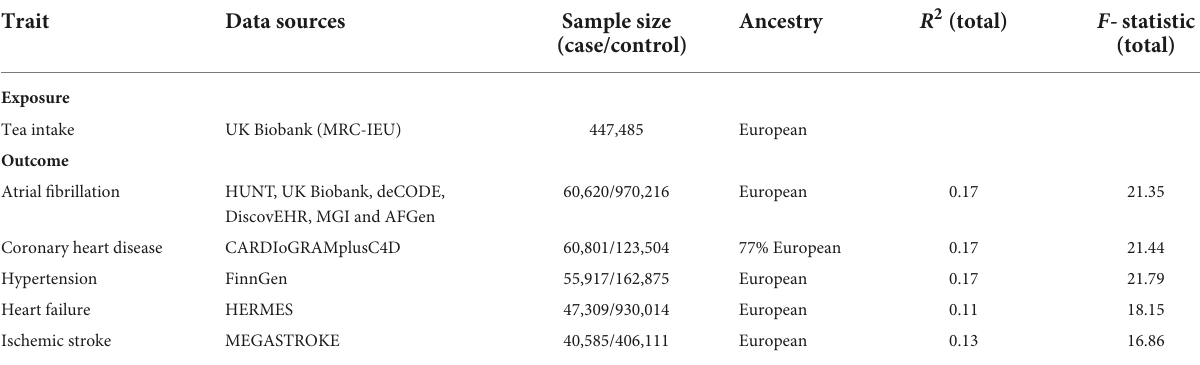
TABLE 1 Data sources and instrumental variables strength